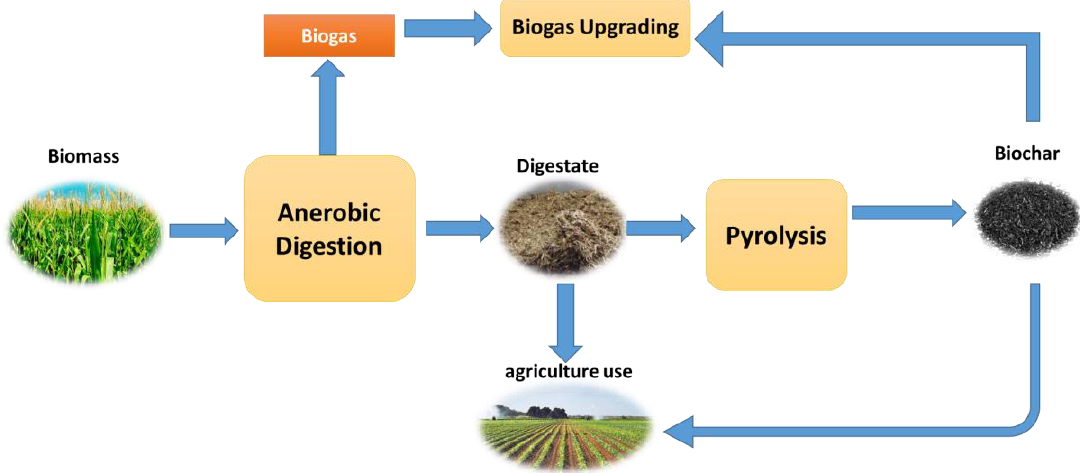
Figure 3. Coupling pathway for digestate-derived biochar Anaerobic digestion of aqueous phase liquid derived from